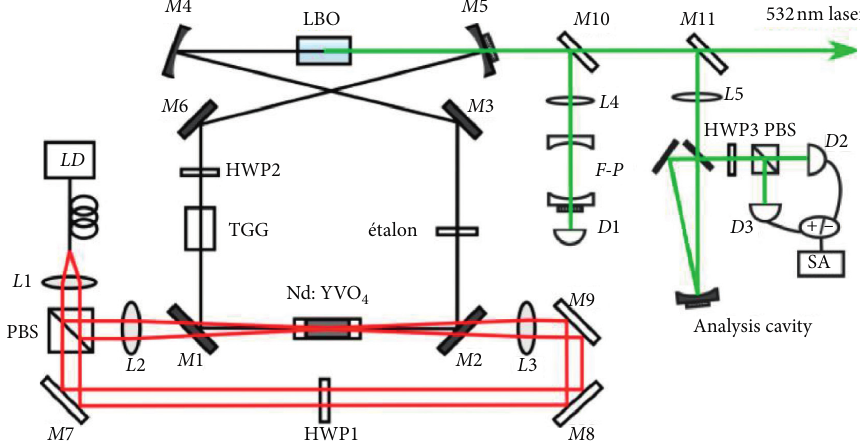
Figure 7: Schematic of the structure of a six-mirror ring cavity single-frequency green laser [45].